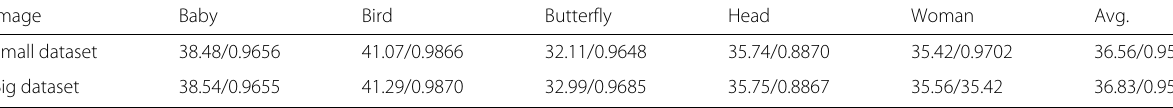
Table 3 Comparison of our proposed ANNet trained with different datasets Image Baby Bird Butterfly Head Woman Avg.